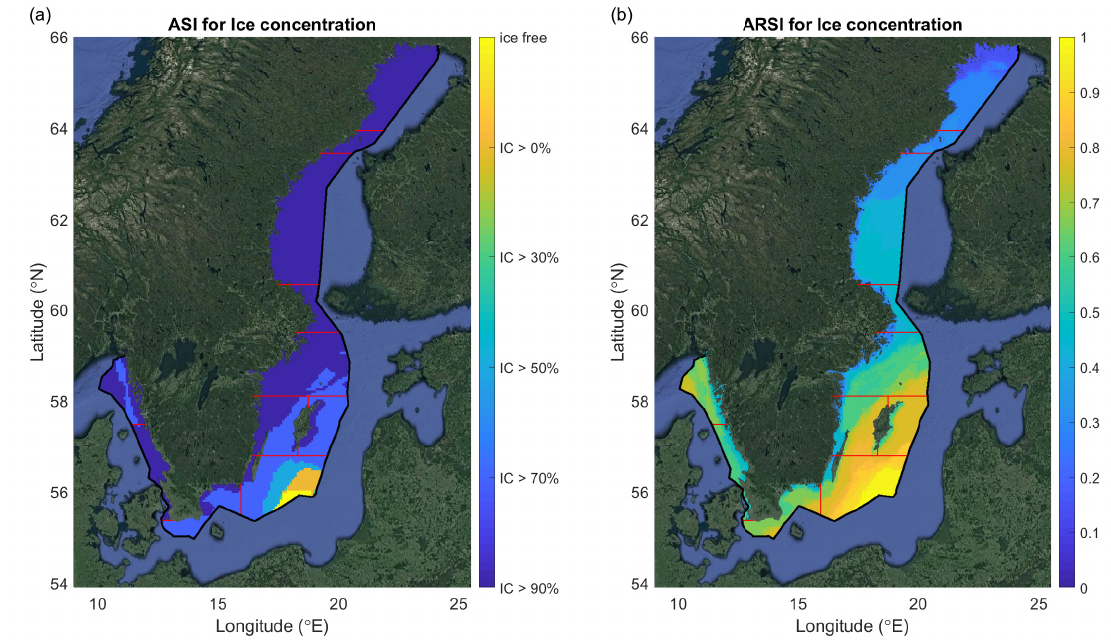
Figure 6. The Average Suitability Index (ASI) for Ice Concentration (IC) based on considering any presence of ice classes (in ( a )) represents the presence of their maximum ice concentration category over 34 years. The percentile limits of Figure 4b are used to formulate the Average Relative Suitability Index (ARSI) in ( b ), which takes into account the amount of time of various ice concentration categories. A value of one indicates ice-free or non-critical ice concentration conditions for all categories considered, and low values imply the presence of potentially critical ice concentration conditions for many of the categories (or thresholds) considered. Sub-basin borders following Figure 1 are marked with red